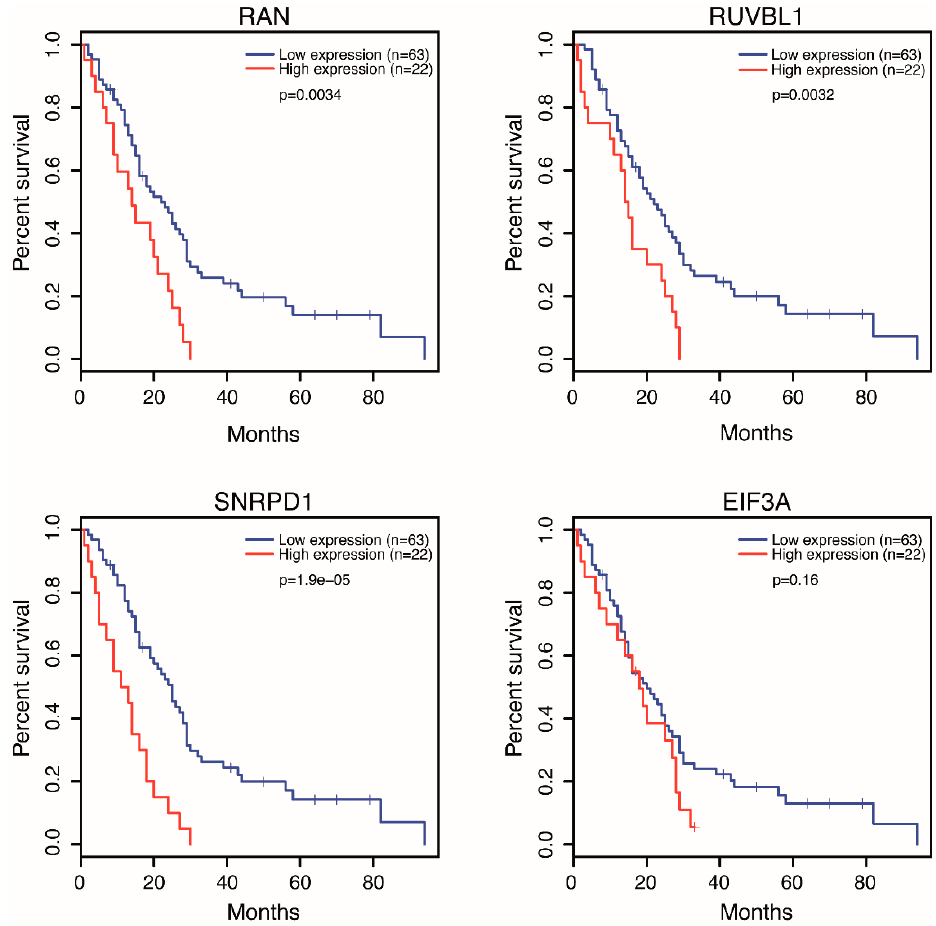
Figure 2. Overall survival rates of MPM patients according to low and high expression levels of select genes.